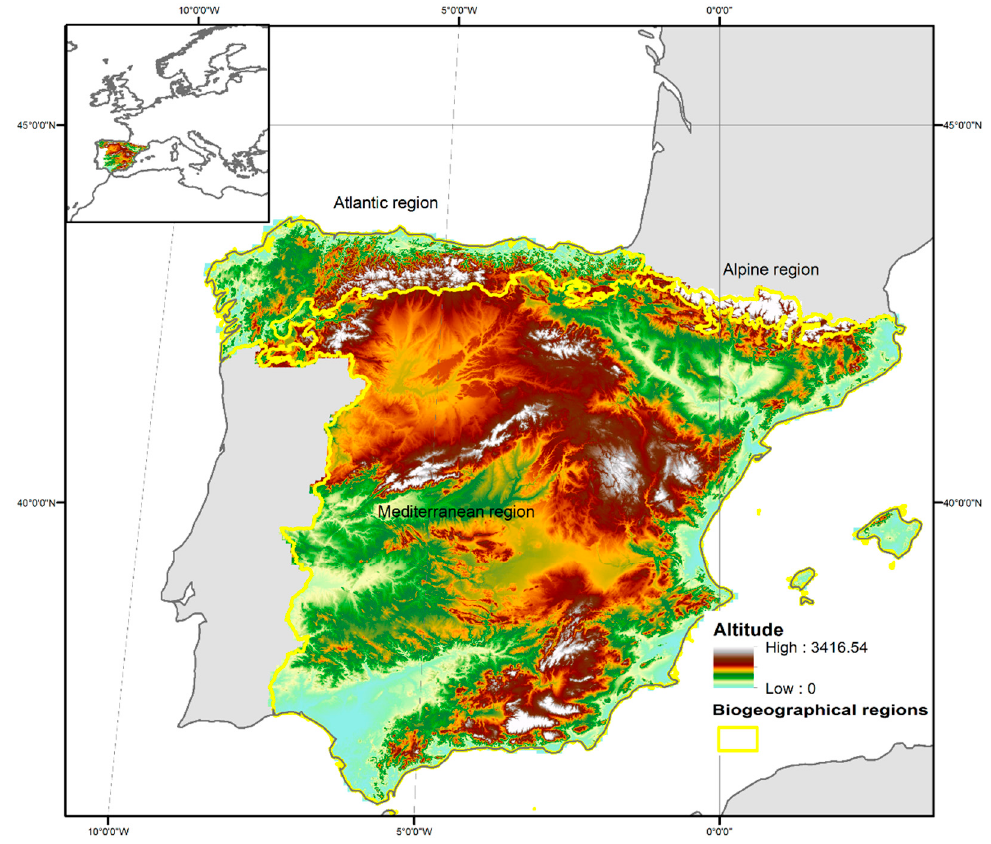
Figure 1. Map of our study area with biogeographical regions (Mapa de regiones biogeográficas estatal; © Ministerio para la Transición Ecológica (MITECO)).